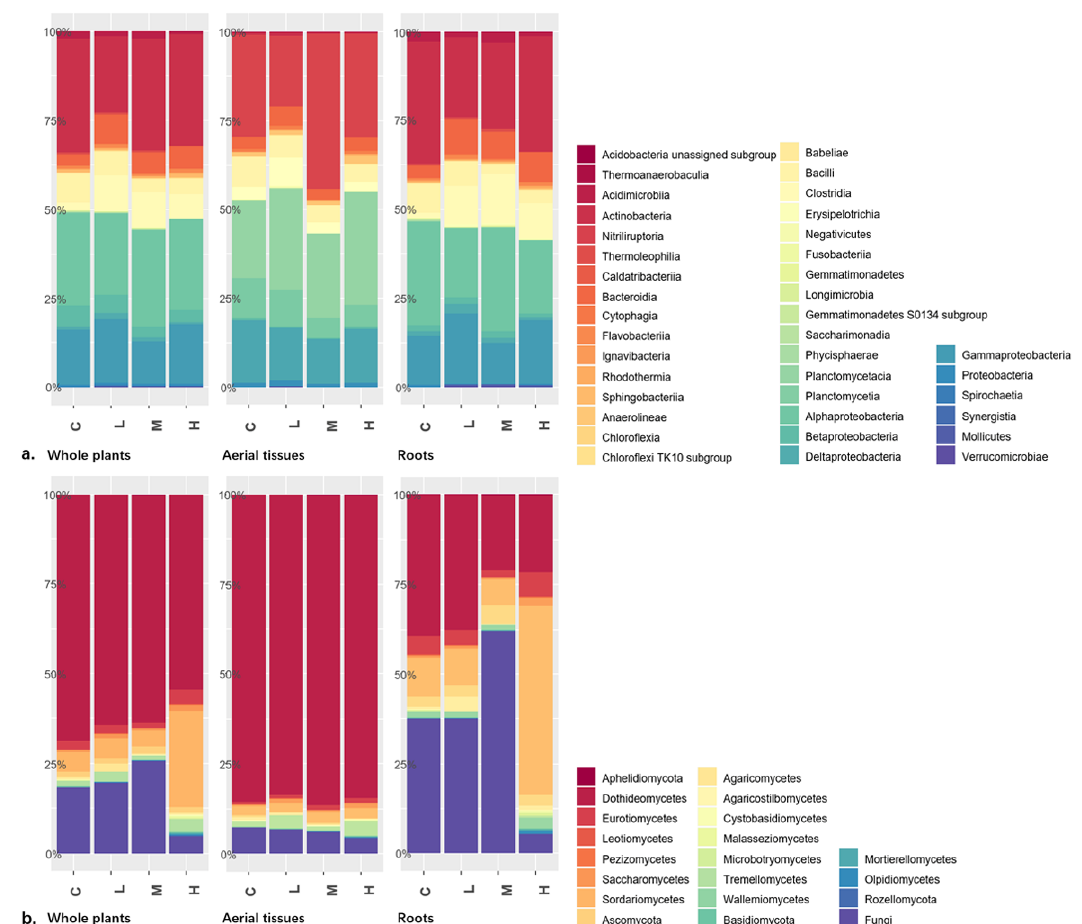
Figure 1. The community composition of endophytes at class or higher levels in whole plants, and aerial tissues or roots separately: ( a ), the composition of bacterial classes which were relatively even between different tissues; ( b ) the composition of fungal classes which showed dramatic difference between aerial tissues and roots. C, L, M, and H in x-axis represented control, low, medium, and high level ionizing radiation treatments, respectively.